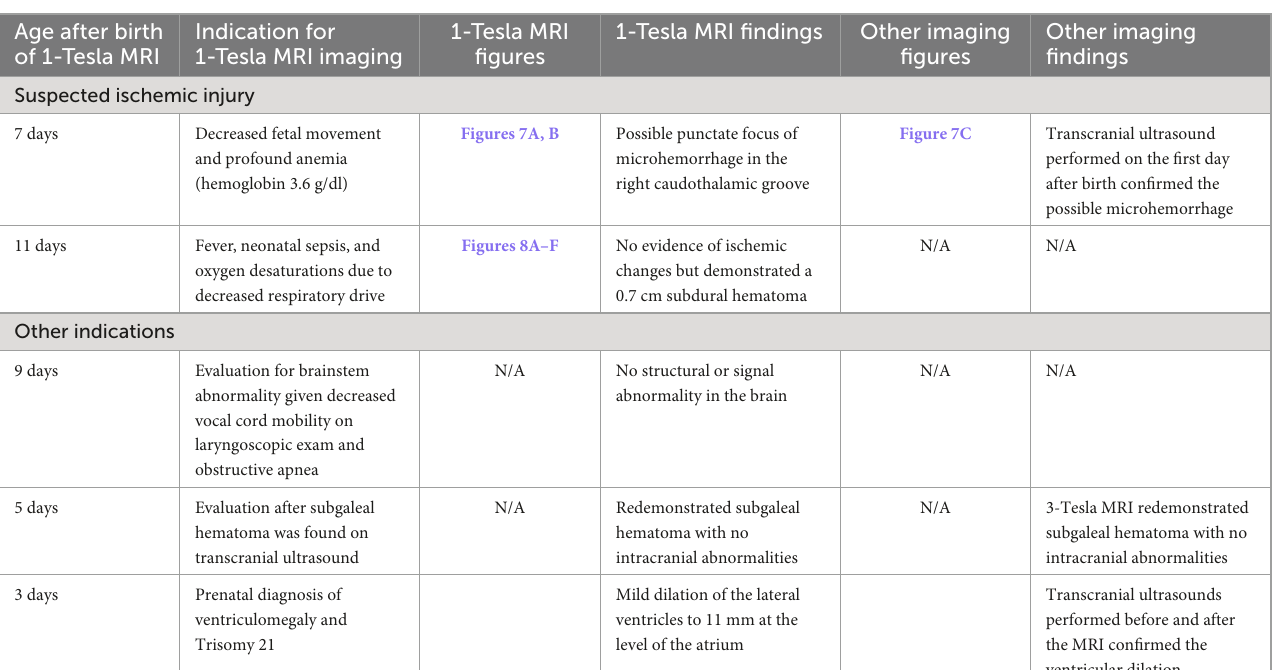
TABLE 2 Descriptors of infants who underwent 1-Tesla brain MRI